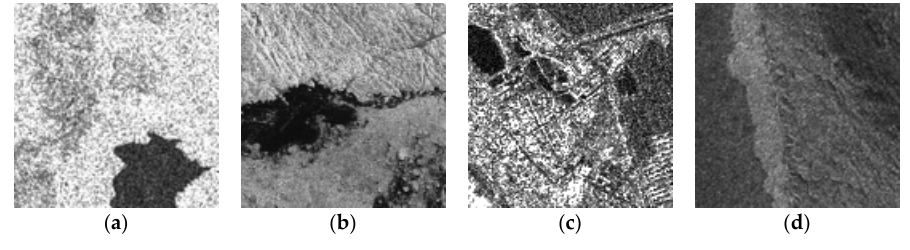
Figure 7. Four real SAR images ( a – d ).